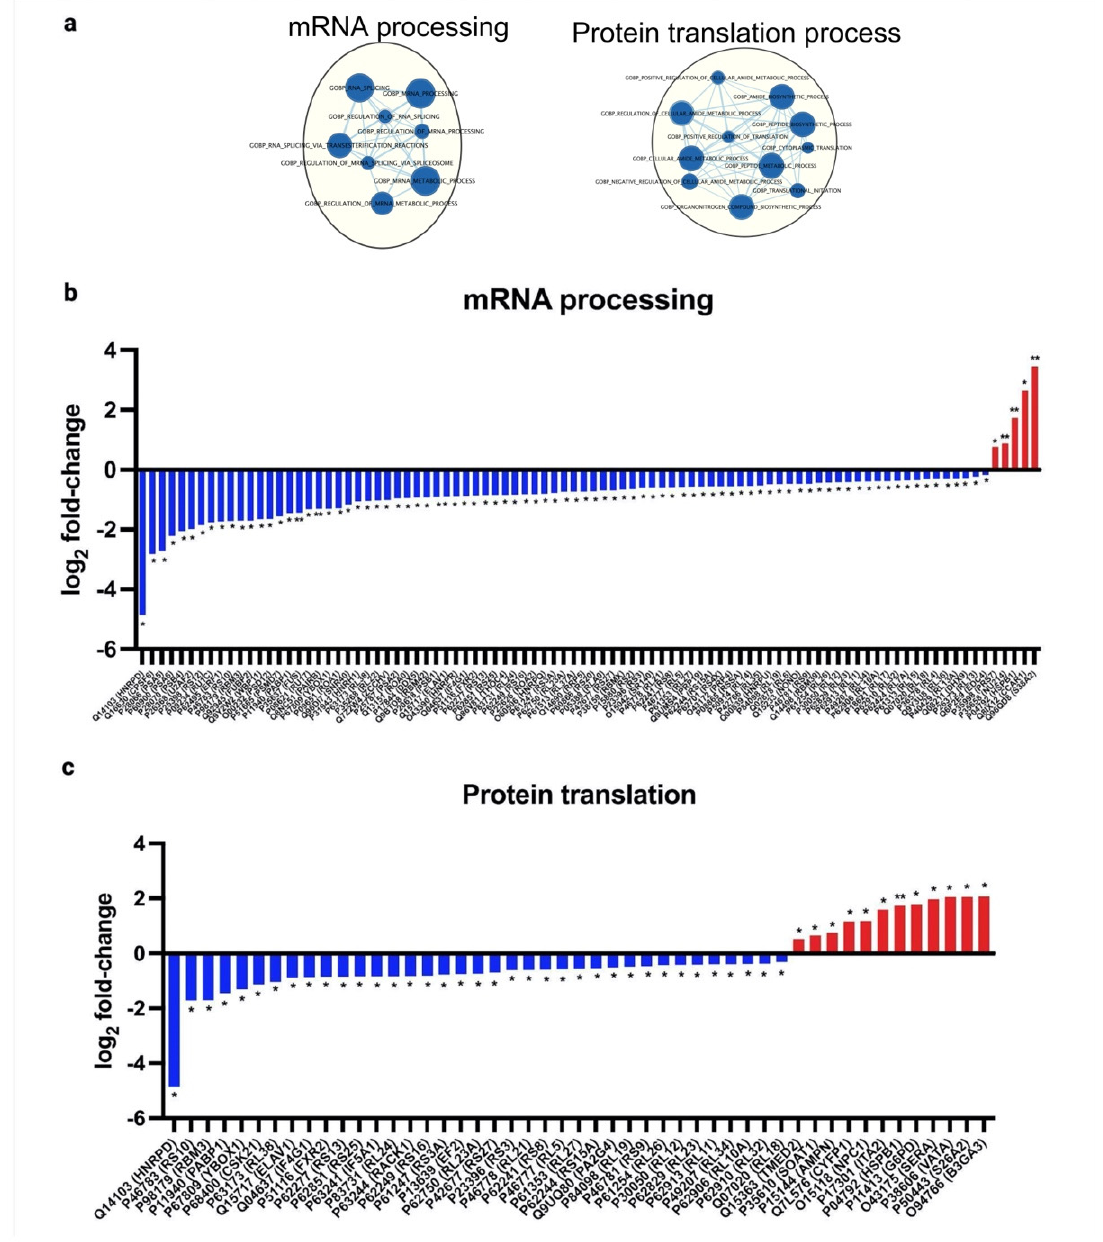
Figure 3. Pictilisib treatment also significantly affected pathways involving mRNA processing and protein translation in A549. ( a ) Based on the GSEA analysis, clusters of pathways involved in mRNA processing and protein translation are downregulated. Most genes involved in mRNA processing ( b ) and protein translation ( c ) are significantly underexpressed following pictilisib treatment. The data represent mean ± SD; n = 3. The statistical differences were detected utilizing multiple t -test with FDR correction, * q < 0.05; ** q < 0.01.